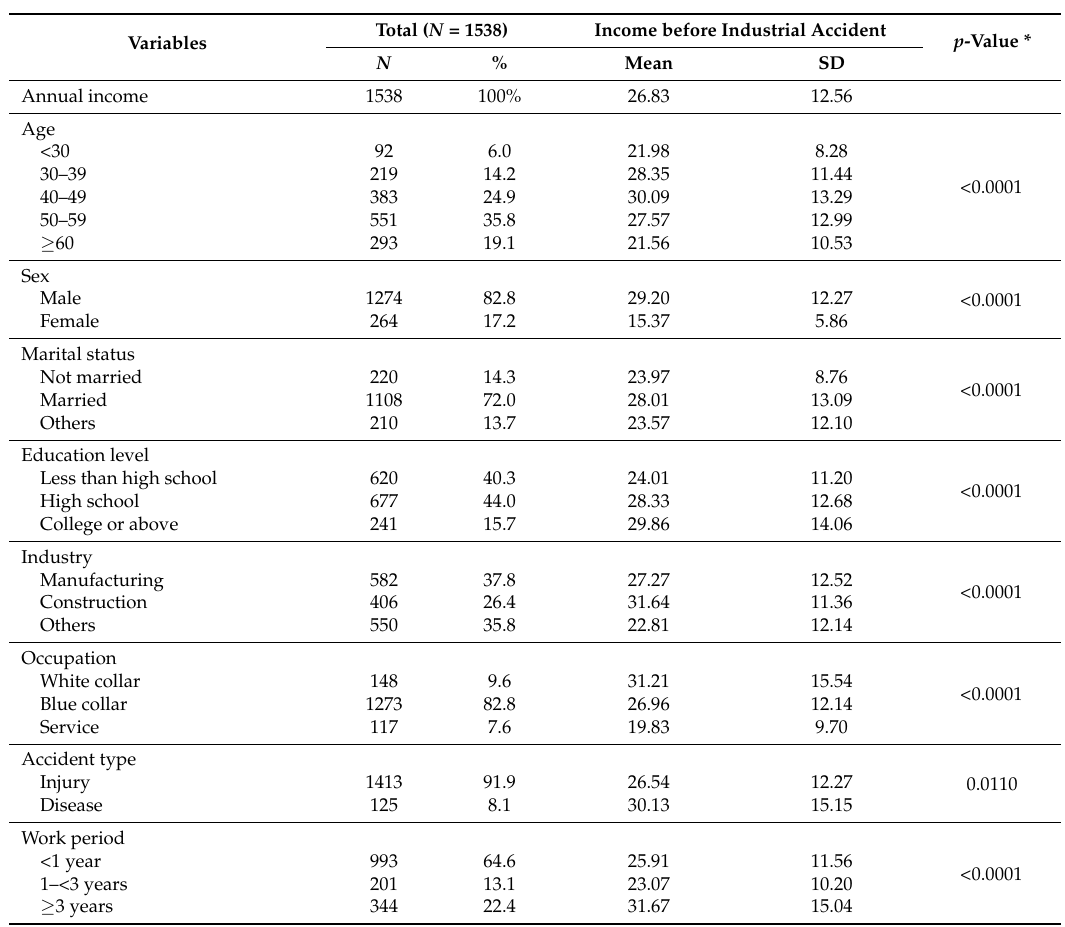
Table 1. General characteristics of study subjects by annual income before industrial accidents status (unit: million